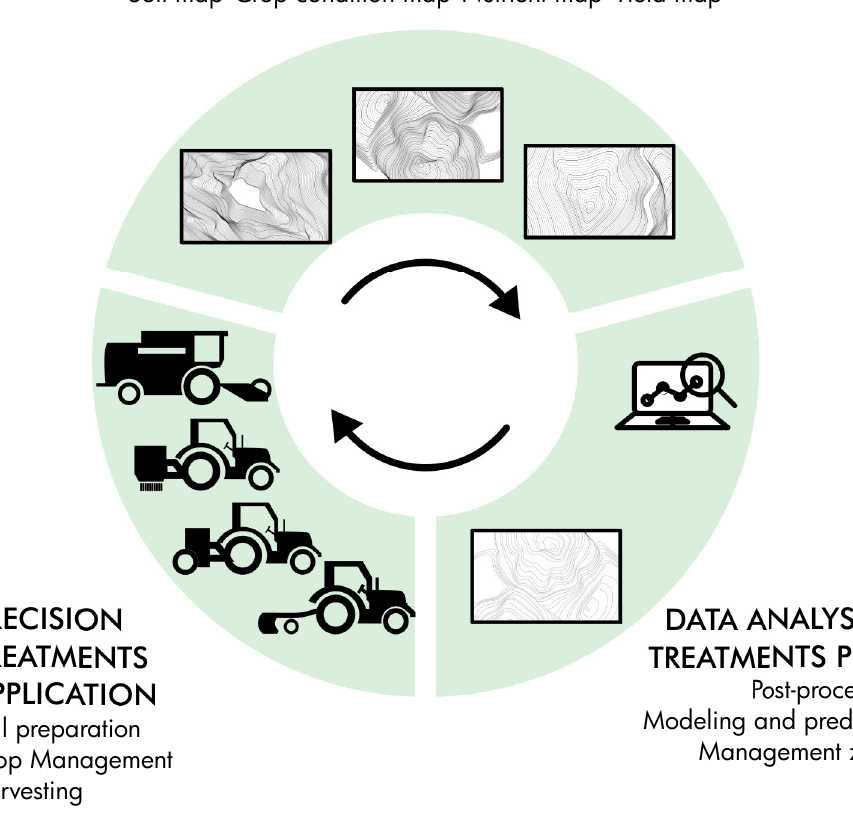
Figure 1. The precision agriculture cycle and its main